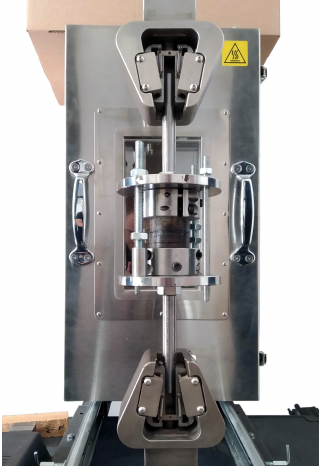
Figure 2. Construction for pull-off tests fixed in loading frame. In the middle, there is a sandwiched specimen